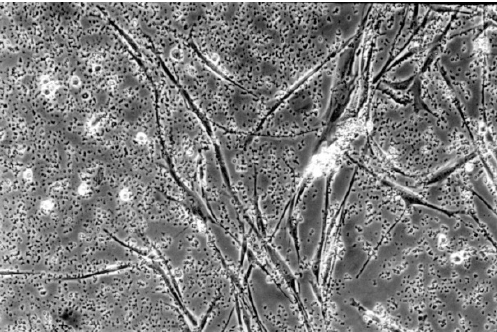
Figure 10. The cell culture exposed to dentin Adhesive Syntac (No. 5) is much less dense than the cell control, with many rounded and dead cells (100-fold magnification).